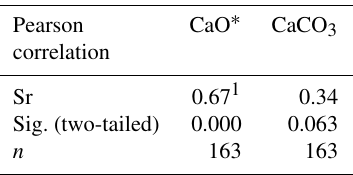
Table 3. Results of a significance test for the correlations among CaO ∗ , CaCO 3 , and Sr. Pearson CaO